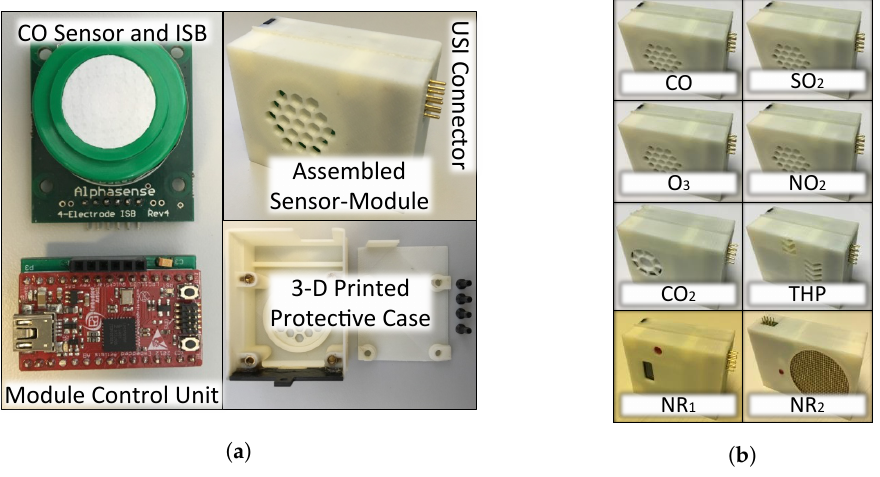
Figure 4. Sensor-Module subsystems. ( a ) a CO Sensor-Module subsystem; ( b ) eight implemented